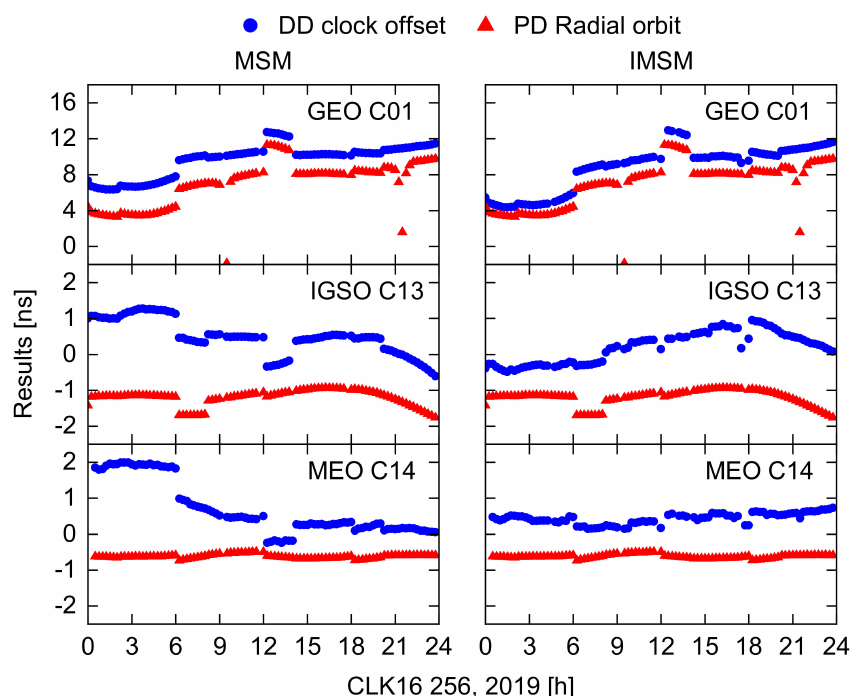
Figure 5. Product-di ff erenced (PD) radial orbits and double-di ff erenced (DD) clock o ff sets derived from the multi-satellite method (MSM) and improved multi-satellite method (IMSM) for the real-time clock product CLK16 on day of year 256,